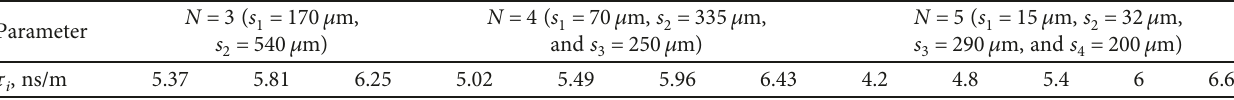
Table 2: Values of s i and per-unit-length delays after optimization using a heuristic search. Parameter